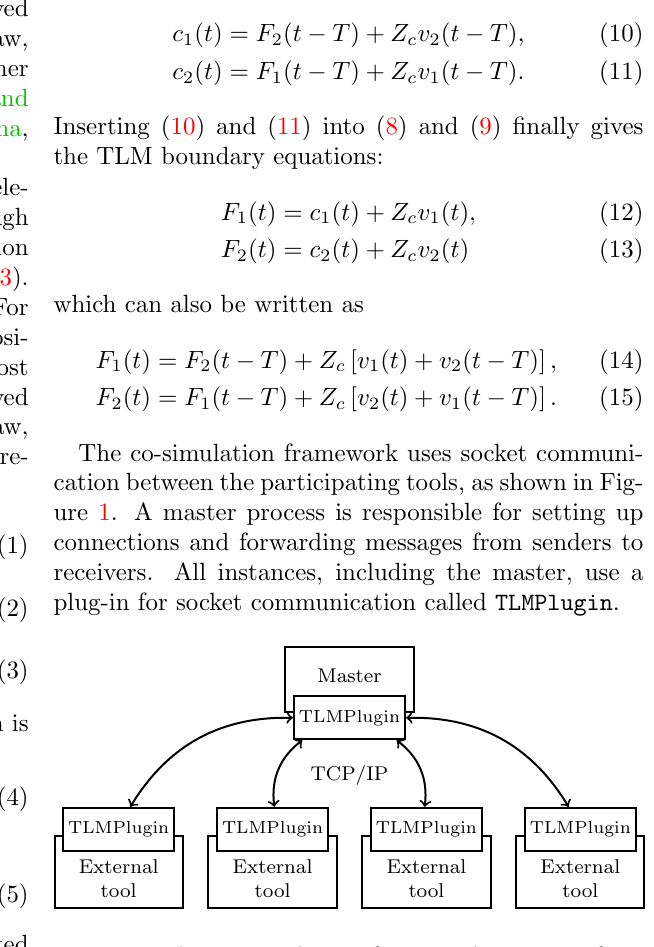
Figure 1: The co-simulation framework consist of in- terconnected external tools, communicating through a master using TCP/IP